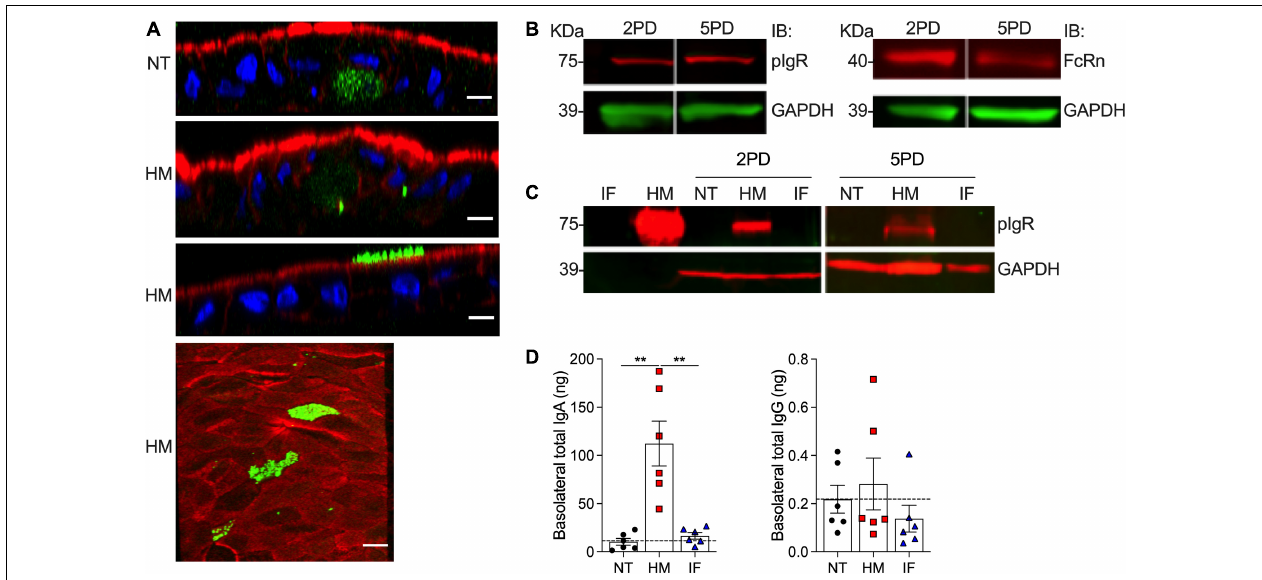
FIGURE 5 | Abundance of pIgR and sIgA translocation in breast milk-treated epithelial monolayers. (A) Confocal microscopy images showing SC-pIgR (top, XZ projections, scale bar = 10 µ m; bottom, XY projection, scale bar = 5 µ m) in 5PD enteroid monolayer NT or treated with 20% (v/v) of HM for 72 h. SC-pIgR, green; actin, red; DNA, blue. (B) Composite immunoblotting (IB) showing SC-pIgR and FcRn expression in NT 2PD and 5PD monolayers. (C) IB showing the presence of pIgR in HM and its absence in IF, and pIgR staining in 2PD and 5PD monolayers NT or treated for 48 h with 20% HM (v/v) or IF (w/v). (D) Total IgA and IgG determined by ELISA in the basolateral media of pediatric monolayers treated with HM and IF as described in panel (C) . Data represent mean ± SEM of three experiments, each including two monolayers/group per experiment. Each symbol indicates an independent monolayer. Dashed line indicates limit of detection. p -value was calculated by Student’s t -test. ** P <